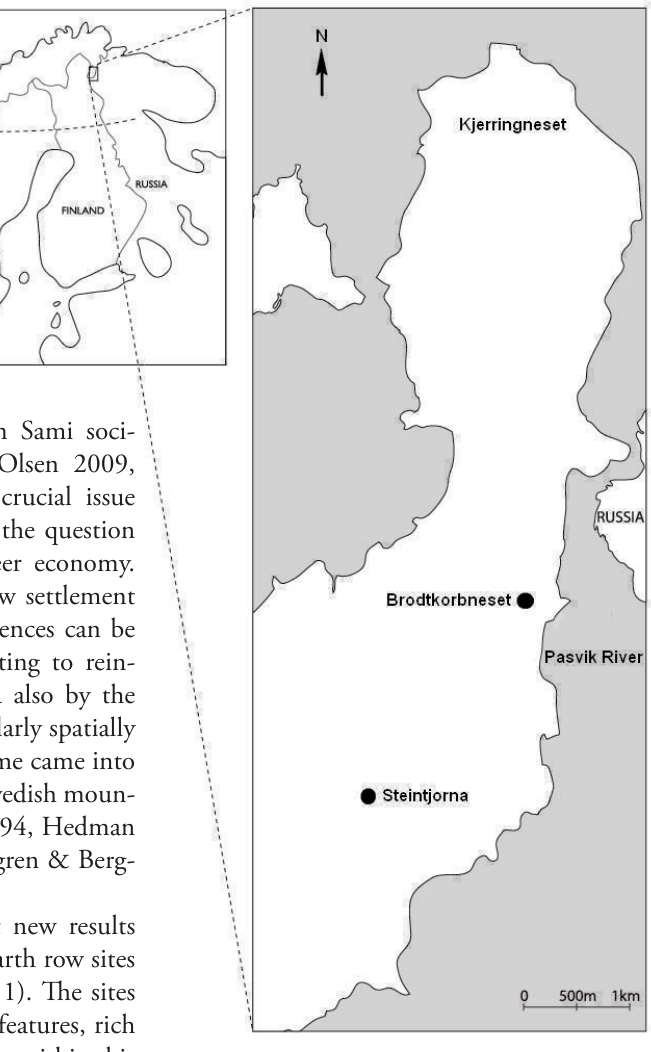
Figure 1. Location of the study area with the investigated sites